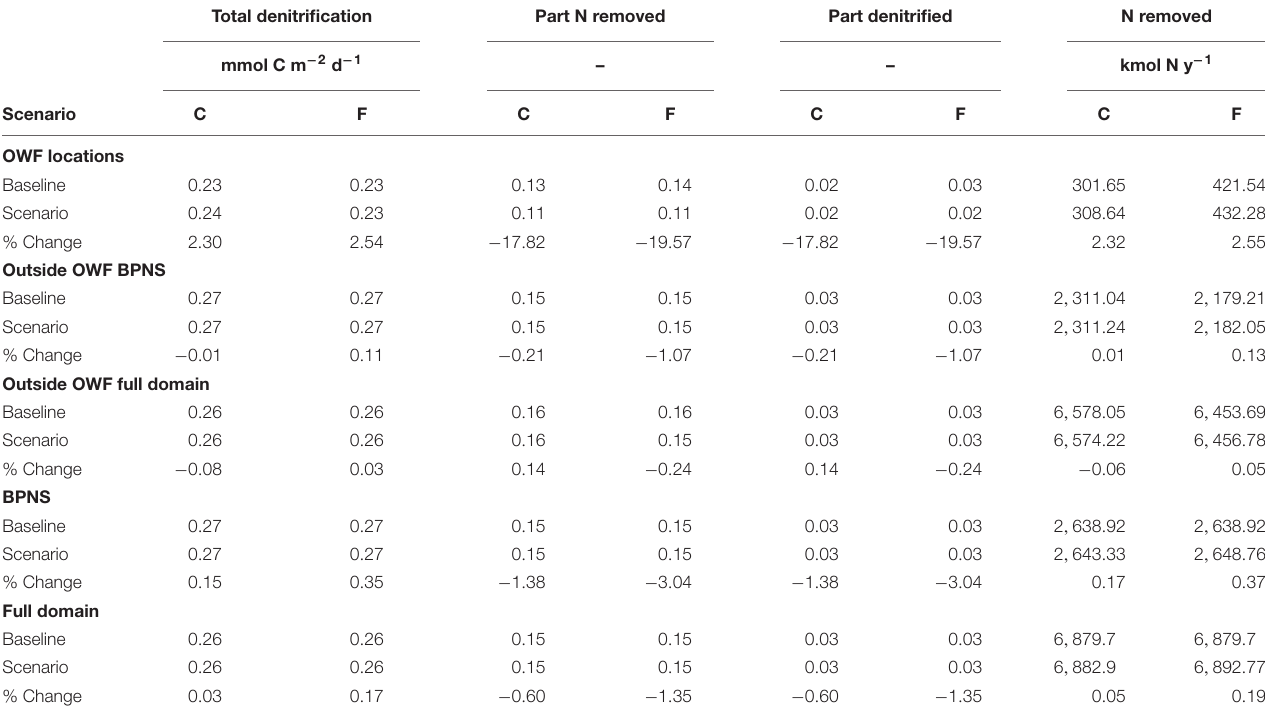
TABLE 5 | Averaged values and relative changes between tested scenarios and the baseline of carbon mineralization processes for the current (C) and future (F) scenarios, subdivided in values over locations with OWFs, the BPNS excluding OWFs (far-field BPNS), the domain excluding OWFs (Far-field domain), the BPNS, and the full